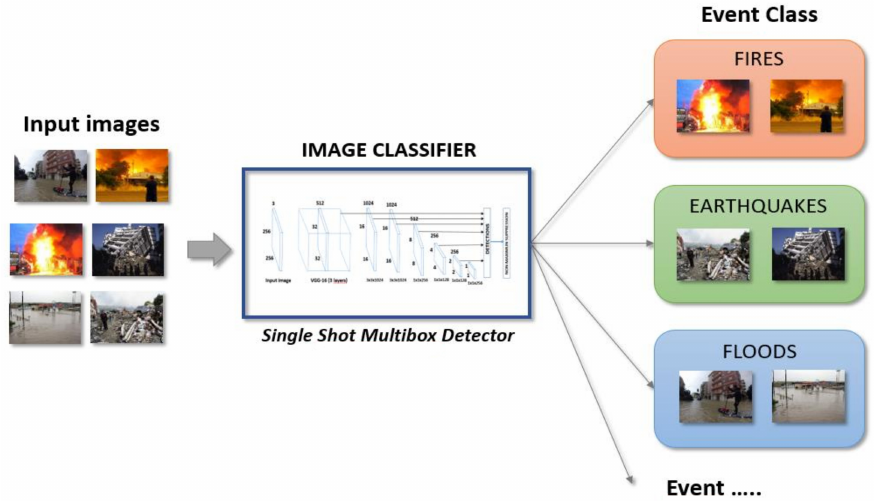
Figure 6. The Single Shot Multibox Detector (SSD) network used for event class detection.